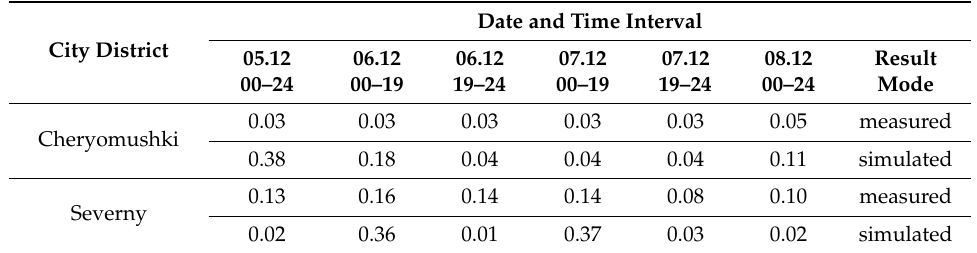
Table 7. SO 2 concentrations in shares of peak maximum permissible concentration (MPC, 500 μ g/m 3 ).